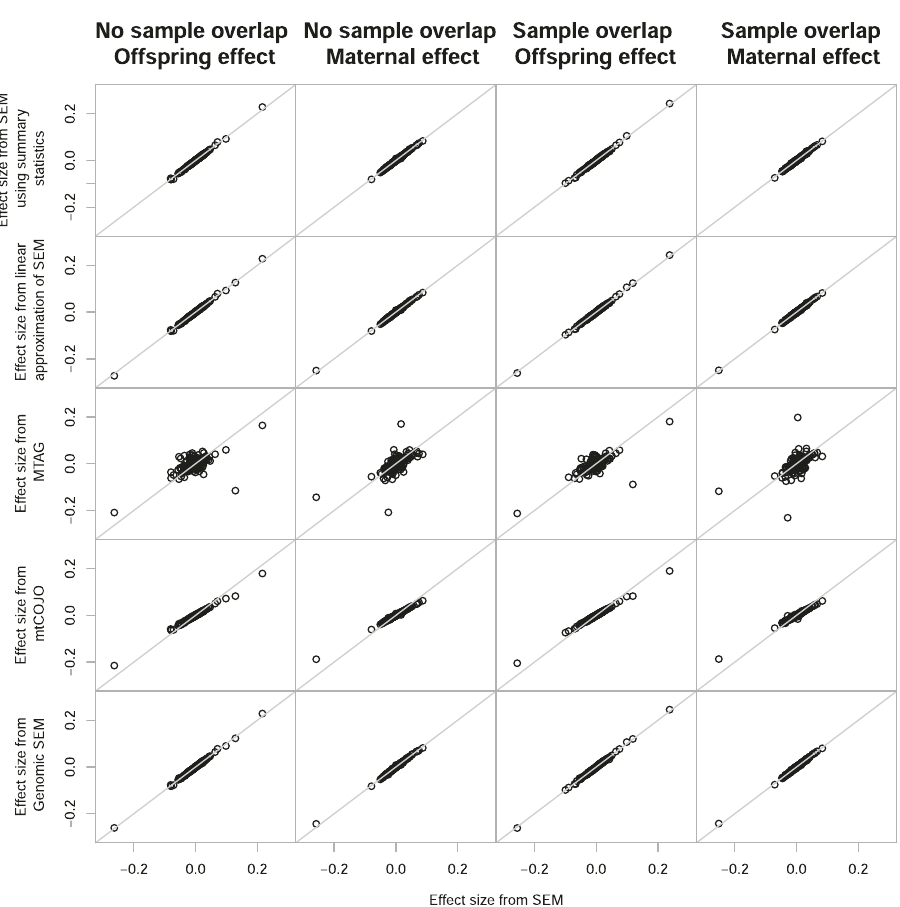
Fig. 1 Comparison of the effect size estimates from the SEM using individual level data ( x -axis) and the various different methods using the summary statistics from the GWAS of own and offspring birth weight ( y -axis) for the 300 autosomal genome-wide signi fi cant SNPs from Warrington et al. 3 . The columns summarize the results from the analysis including unique individuals in the GWAS of own and offspring birth weight for the offspring and maternal effect, respectively, followed by the results from the analysis where there were overlapping samples in the GWAS of own and offspring birth weight for the offspring and maternal